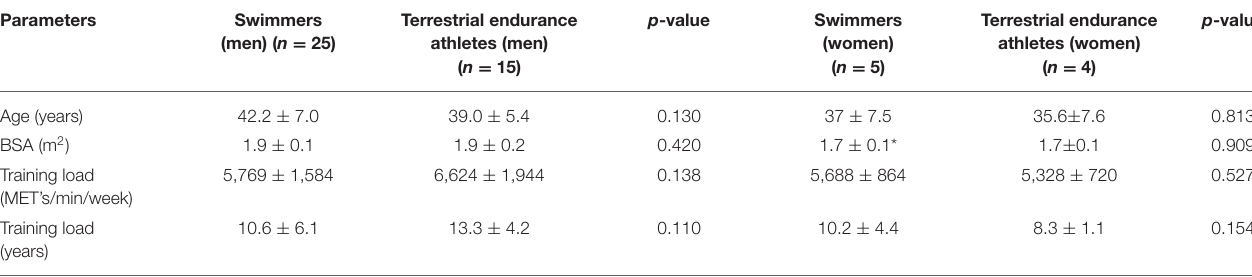
TABLE 1 | Clinical and functional characteristics. Parameters